Question: Generate an informative caption for the figure above.
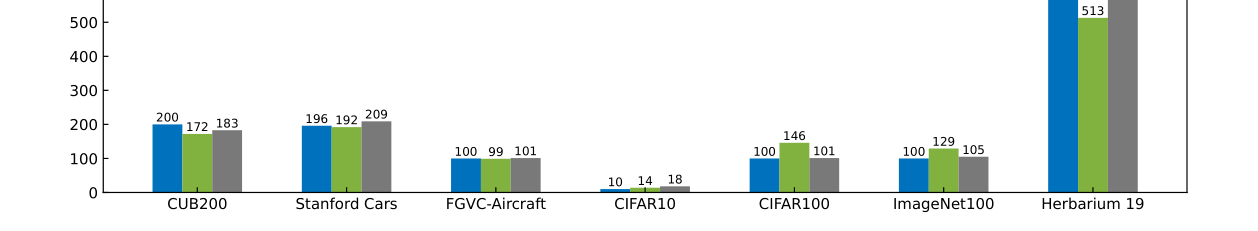
Answer: Category number of the unlabelled data given by the ground truth and estimated by DCCL and our proposed method.